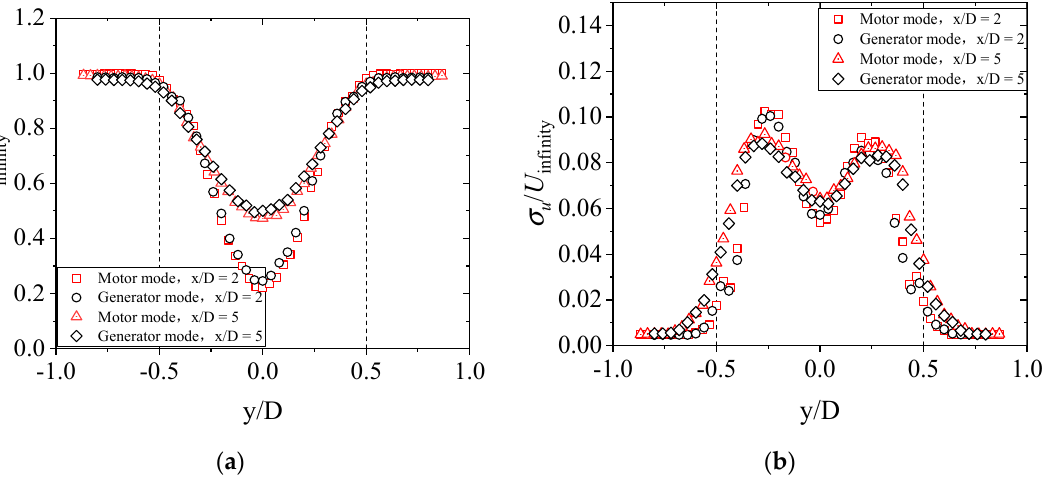
Figure 6. An analysis of different driving modes for the wake of a wind turbine (x/D = 2, 5). ( a ) Mean velocity; ( b ) turbulence intensity.